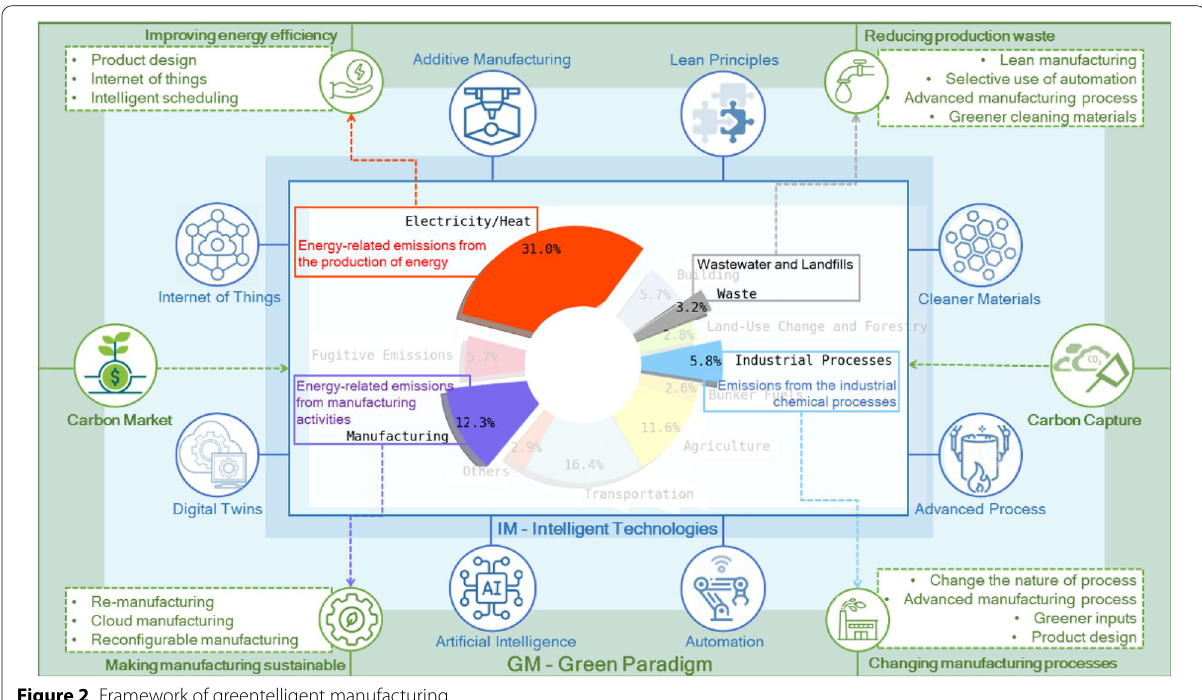
Figure 2 Framework of greentelligent